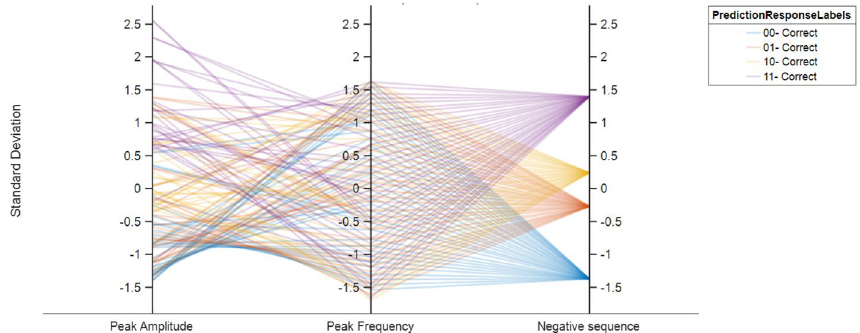
Fig. 5 The parallel coordinate plot of the standard deviation between different